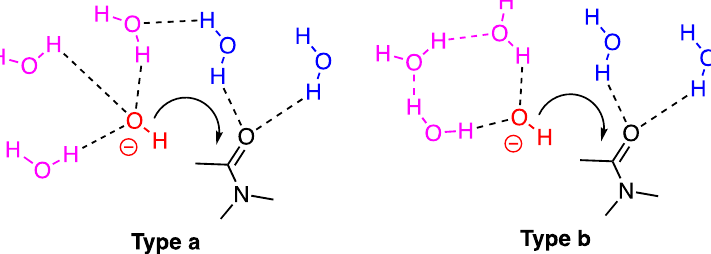
Figure 11. Two hydrogen network patterns involving five H 2 O molecules in the attack of OH anion on the amide carbonyl carbon atom [32].